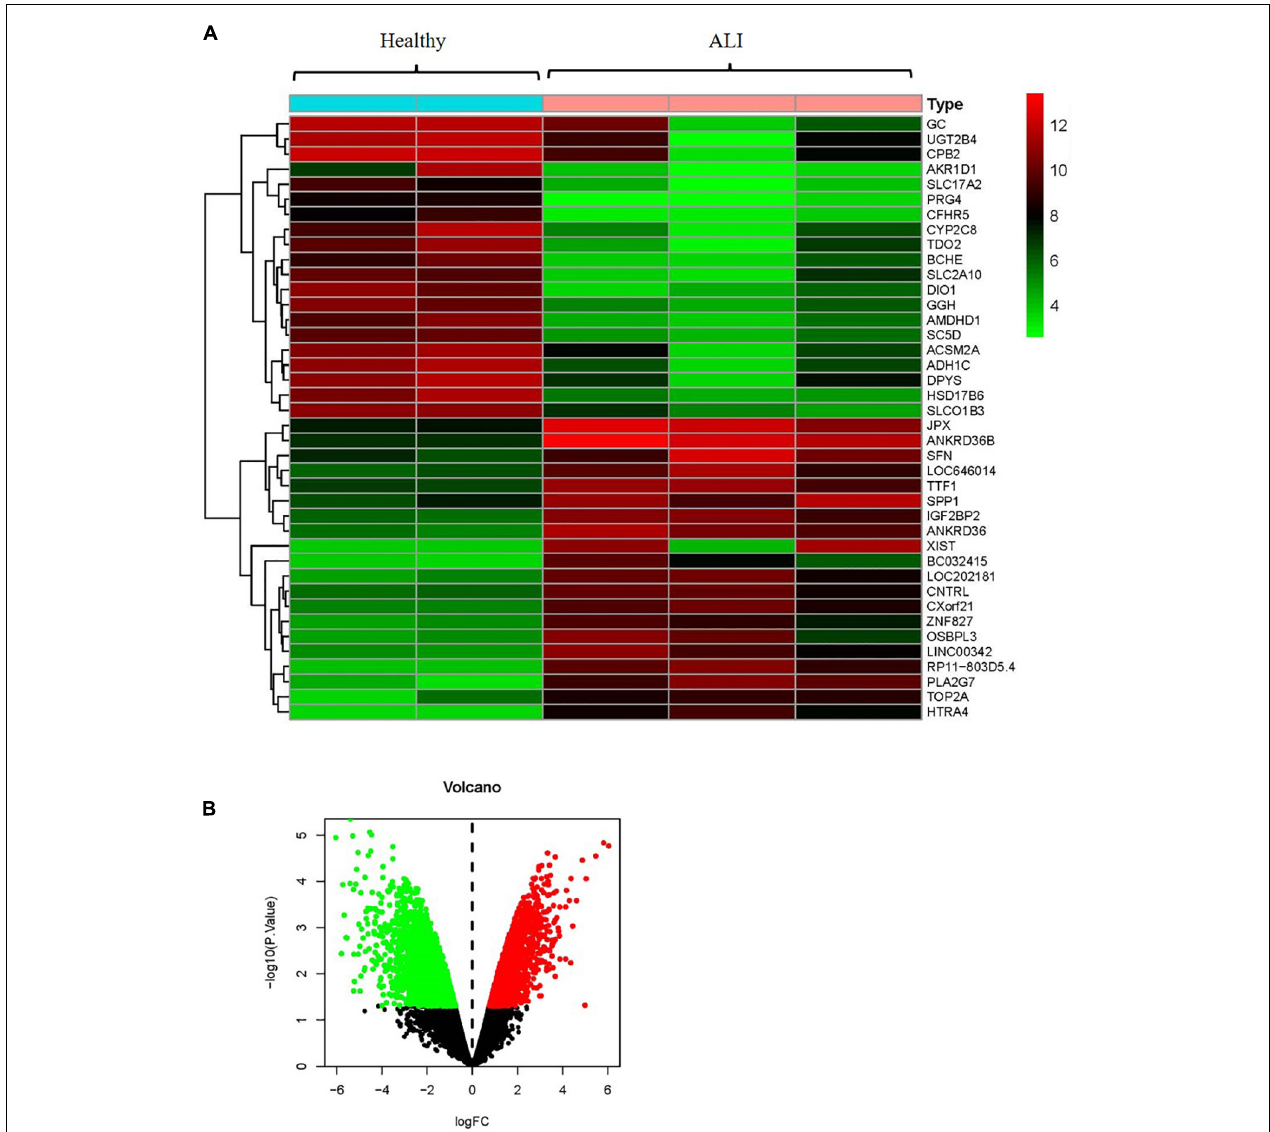
FIGURE 3 | Analyses of the different potential therapeutic targets between ALI and healthy liver tissues. (A) The heatmap comparing the different gene expressions between ALI and healthy liver tissues was shown. (B) The volcano plot of P values as a function of weighted fold change for mRNAs in ALI and healthy liver tissues. The vertical dotted line delimits up- and down-regulation. Red and green plots represent significant up-regulated and down-regulated mRNAs with > 1.2-fold change and corrected P < 0.05, respectively. ALI, acute liver injury.